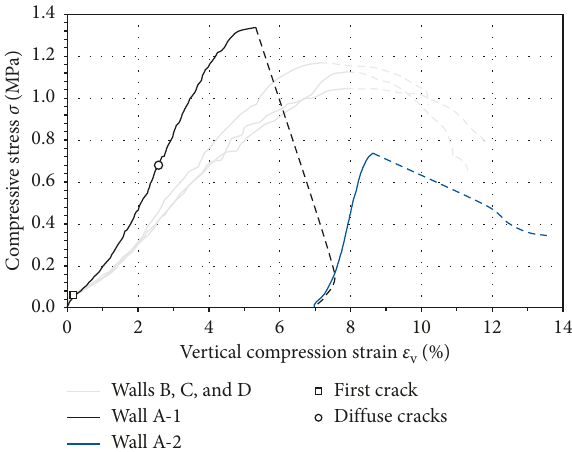
Figure 9: Compressive stress-strain diagrams for the specimen tested at about 0.025 MPa/min (Wall A) and comparison with other tested specimens (about 0.077MPa/min). The reported vertical compression strains are obtained by averaging the displacements measured by the two vertical LVDTs, respectively. Post-peak be- haviour (dotted lines) can be considered as completely reliable since test was force-controlled.